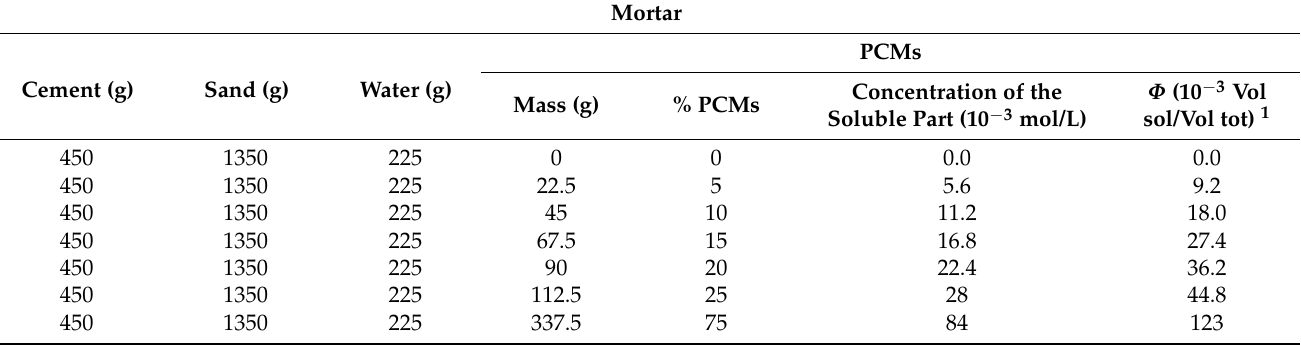
Table 2. Mix design of